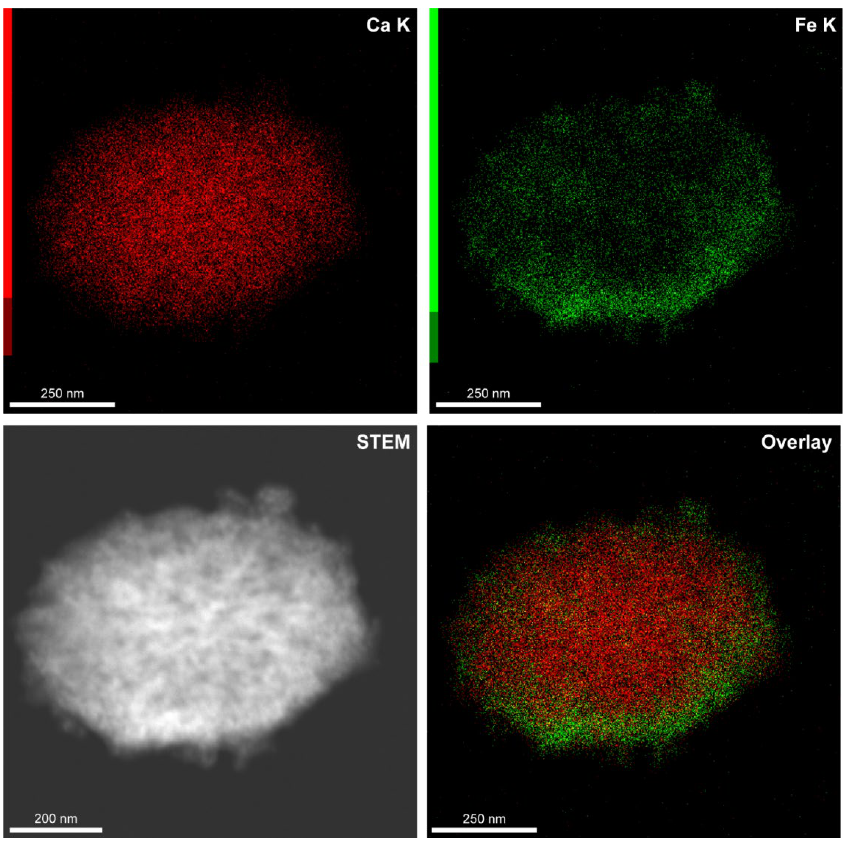
Figure 3. The elemental mapping of a CaCO 3 /MNP 3 /(BSA-Cy7/TA) 2 carrier demonstrating the calcium and iron distribution in the mineral core.